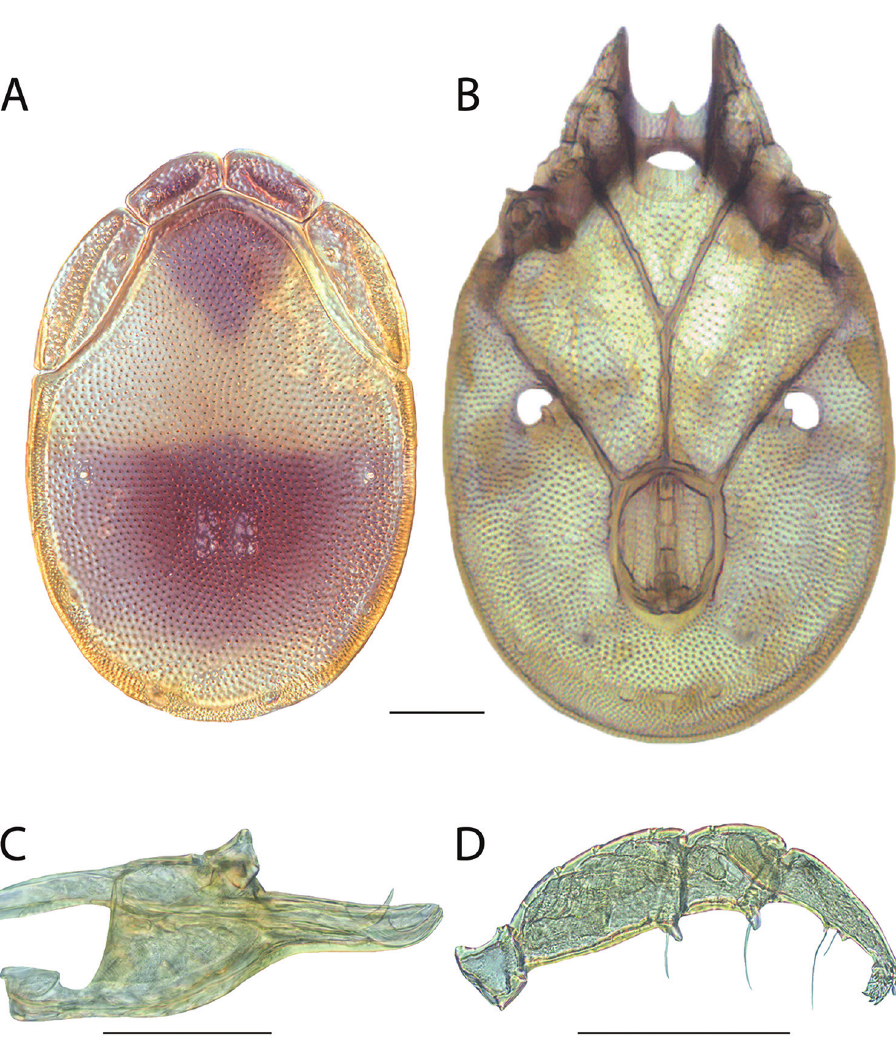
Figure 63. Torrenticola dunni sp. n. male: A dorsal plates B venter (legs removed) C subcapitulum D pedipalp (setae not accurately depicted). Scale = 100